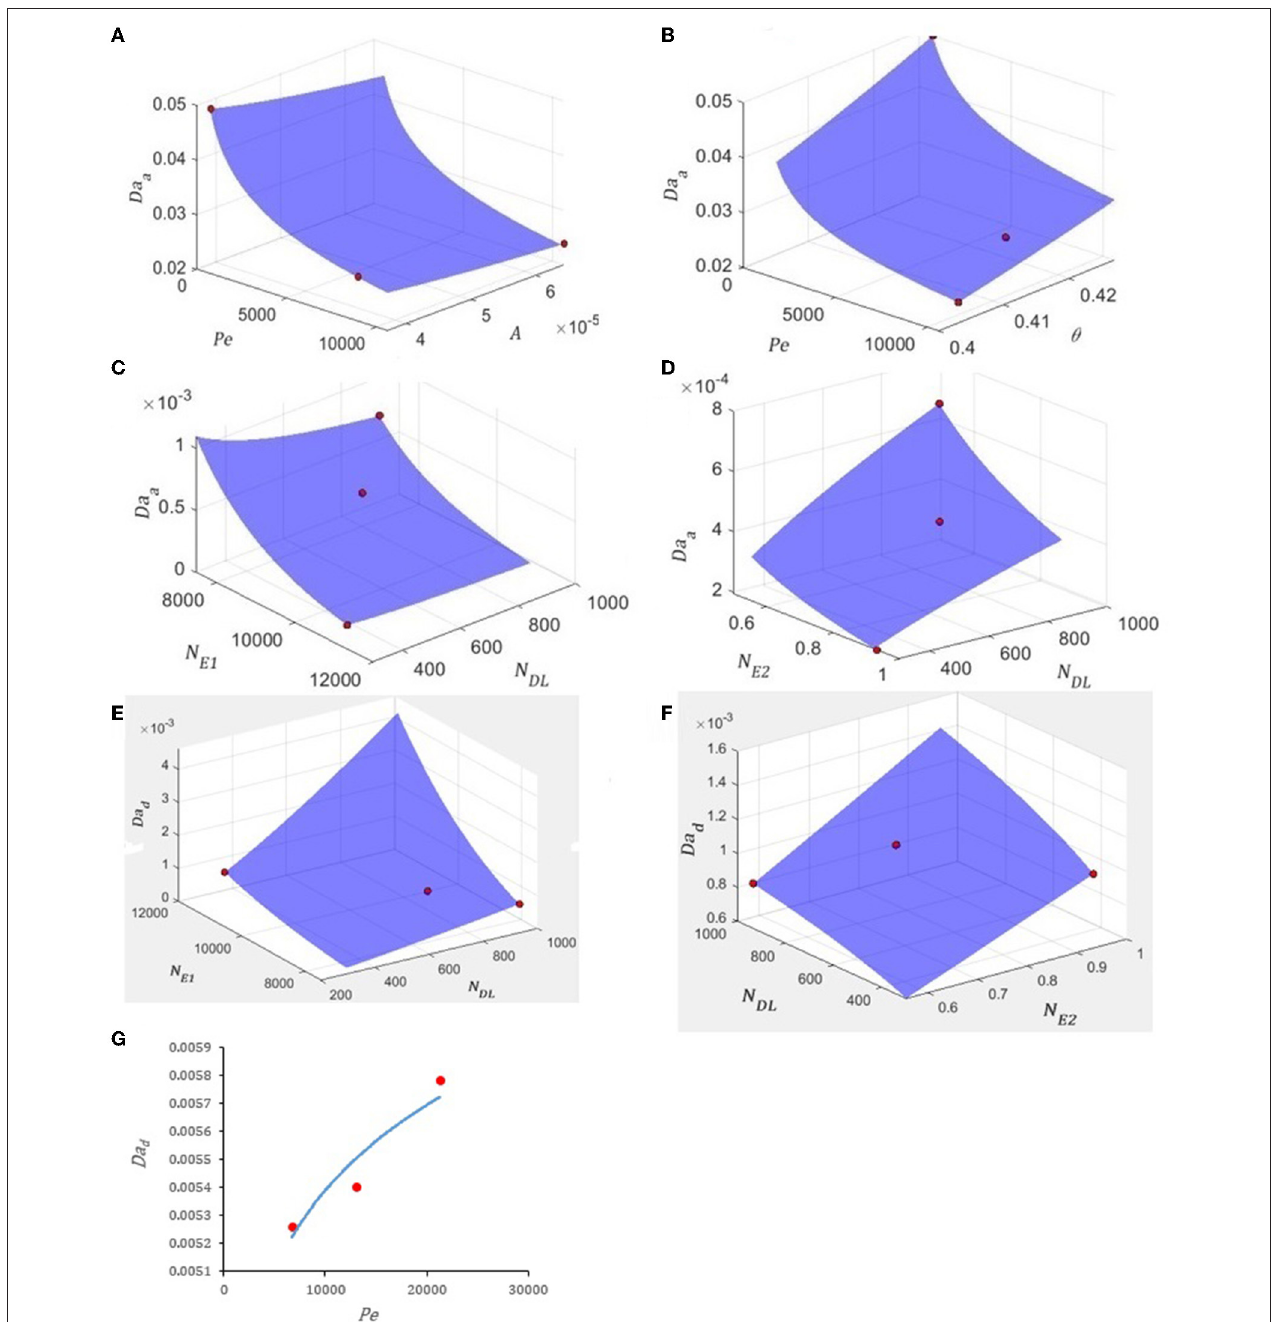
FIGURE 1 | Variation of (A) Da a vs. Pe and A for Ag NPs, (B) Da a vs. Pe and θ for Ag NPs, (C) Da a vs. N E 1 and N DL for CML colloids, (D) Da a vs . N E 2 and N DL for CML colloids, (E) Da d vs. N E 1 and N DL for CML colloids, (F) Da d vs. N DL and N E 2 for CML colloids, and (G) Da d vs. Pe for 8 X 174. The fitted equations are (A,B) Da a = θ 2.926 Pe − 0.199 A − 0.08 and R 2 = 1, (C,D) Da a = N DL 0.3412 N E 1 − 1.129 N E 2 − 0.784 and R 2 = 1, (E,F) Da d = N E 1 − 0.797 N E 21.247 N DL 0.116 and R 2 = 1, and (G) Da d = 0.0026 Pe 0.079 and R 2 = 0.89. The data (red circles) for this figure is from (A,B) Liang et al. (2013), (C,D) Johnson et al. (2007), (E,F) Johnson et al. (2007), and (G) Syngouna and Chrysikopoulos (2013). The values of the other dimensionless parameters are (A,B) λ * = 4.43, N E 1 = 41.25, N E 2 = 0.56, N DL = 2.34, and H * = 0.59, (C,D) θ = 0.38, Pe = 221217.14, A = 0.0079, λ * = 0.035, and H * = 1.68, (E,F) θ = 0.38, Pe = 221217.14 , A = 0.0079, λ * = 0.035, and H * = 1.68, and (G) θ = 0.42 , A = 6.5x10 − 6 , λ * = 7.69, N E 1 = 31.74, N E 2 = 0.96, N DL = 0.43, and H * = 1.82.